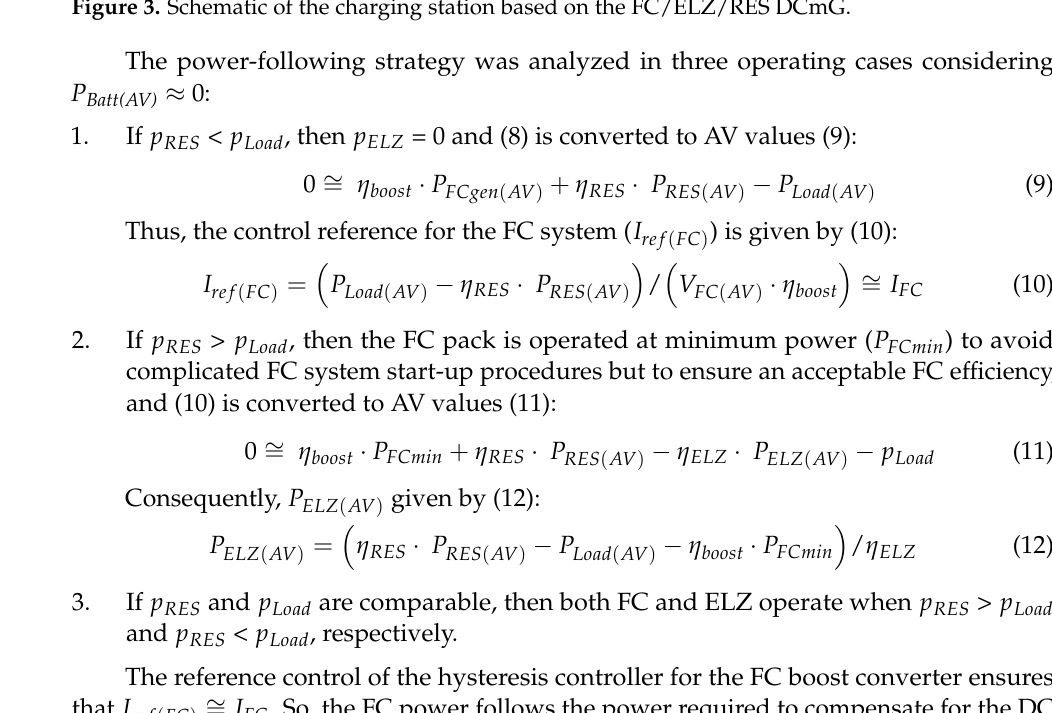
Figure 3. Schematic of the charging station based on the FC/ELZ/RES DCmG.